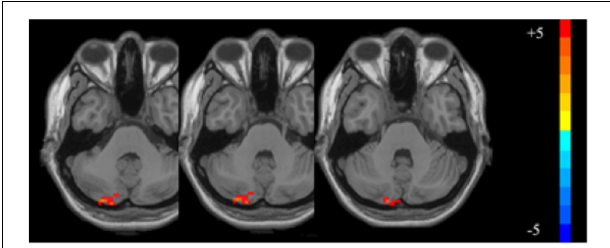
FIGURE 1 | The significantly altered amplitude of low frequency fluctuation (ALFF) map of the left posterior cerebellum in vestibular migraine (VM) patients after vestibular rehabilitation (VR; GRF corrected: p < 0.001, z > 2.65). The color bar denotes the t -value.